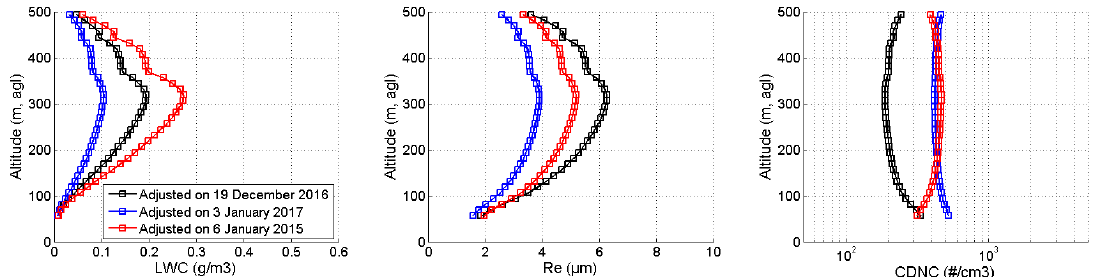
Figure 10. Vertical profiles of LWC, Re and CDNC for 19 December 2016 between 08:00 and 09:00, derived from Equations (3b), (5) and (6) for the 3 pairs of fitted parameters.